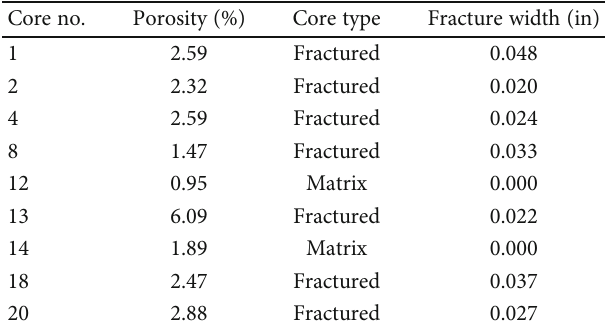
Table 1: Porosity and natural fracture width of the tight sandstone cores.